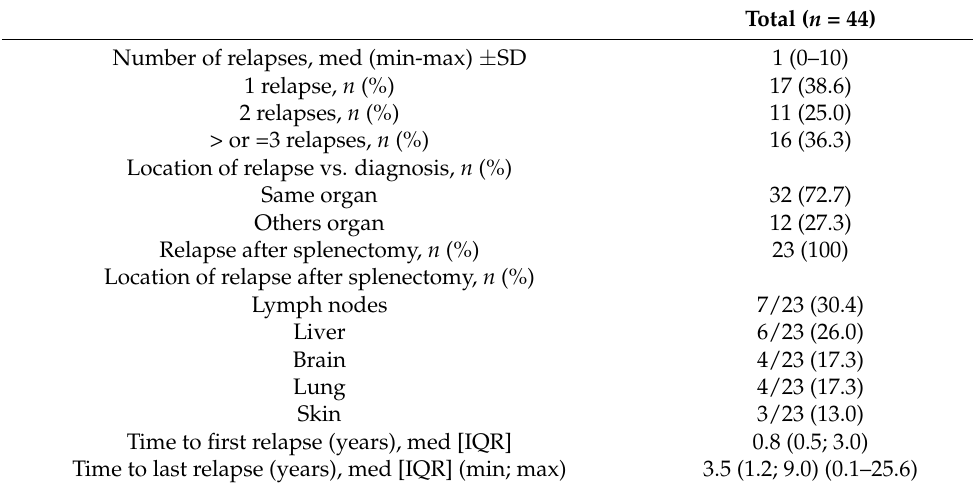
Table 3. Evolution among 44 patients suffering at least one aseptic abscess syndrome